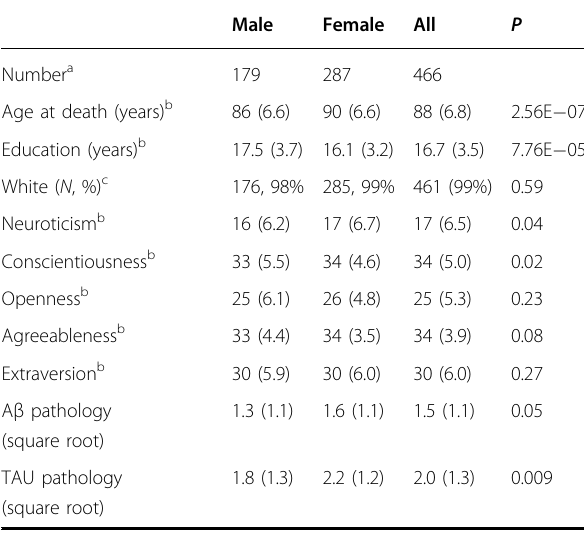
Table 1 Demographic characteristics of the ROSMAP participants used in the